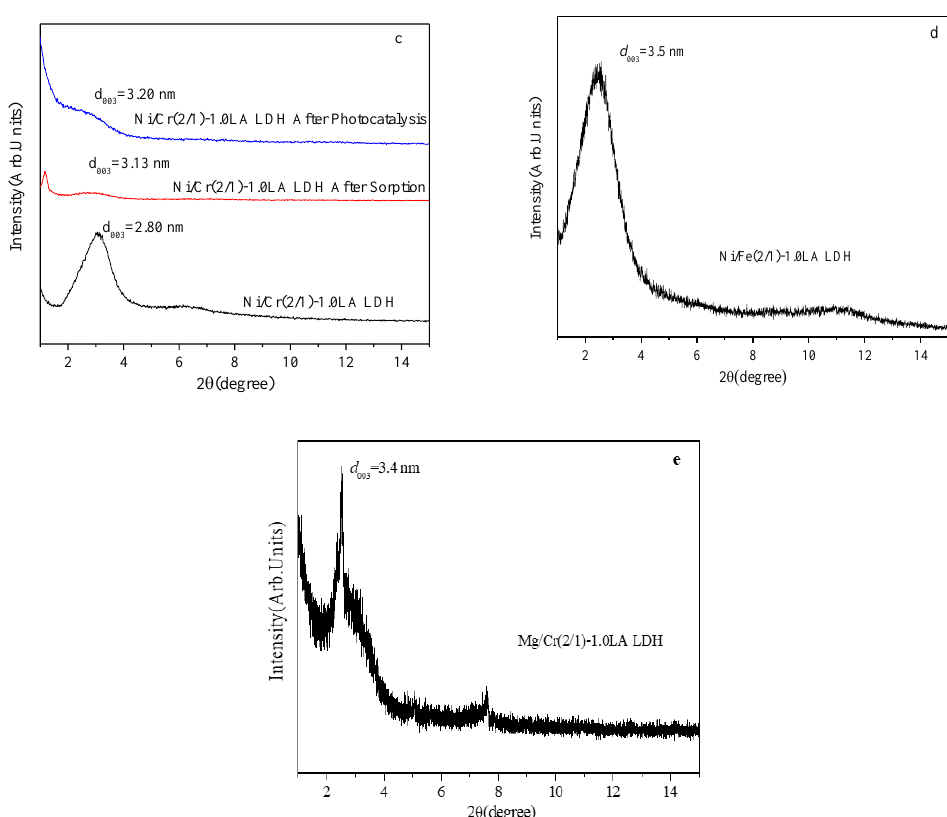
Figure 1. The XRD patterns of ( a ) Ni/Cr(2/1)−xLA LDH (x = 1.0, 0.5) at narrow-angle and wide-angle, ( b ) Ni/Cr−1.0LA LDH (Ni/Cr = 1, 2, 3), ( c ) Ni/Cr (2/1)−1.0LA LDH after adsorption and catalysis, ( d ) Ni/Fe(2/1)−1.0LA LDH, and ( e ) Mg/Cr(2/1)−1.0LA LDH. The XRD patterns of Ni/Cr(2/1)−1.0LA LDHs after photocatalysis and sorption are shown in Figure 1c. The d 003 values of Ni/Cr(2/1)−1.0LA LDHs after photocatalysis and